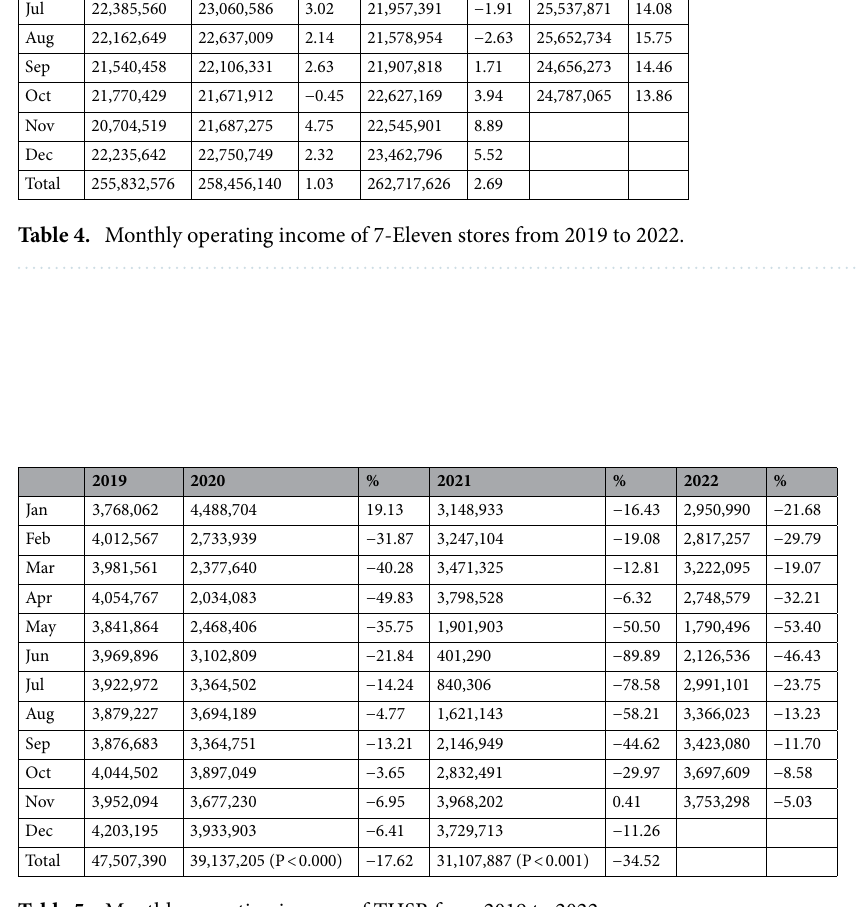
Table 5. Monthly operating income of THSR from 2019 to